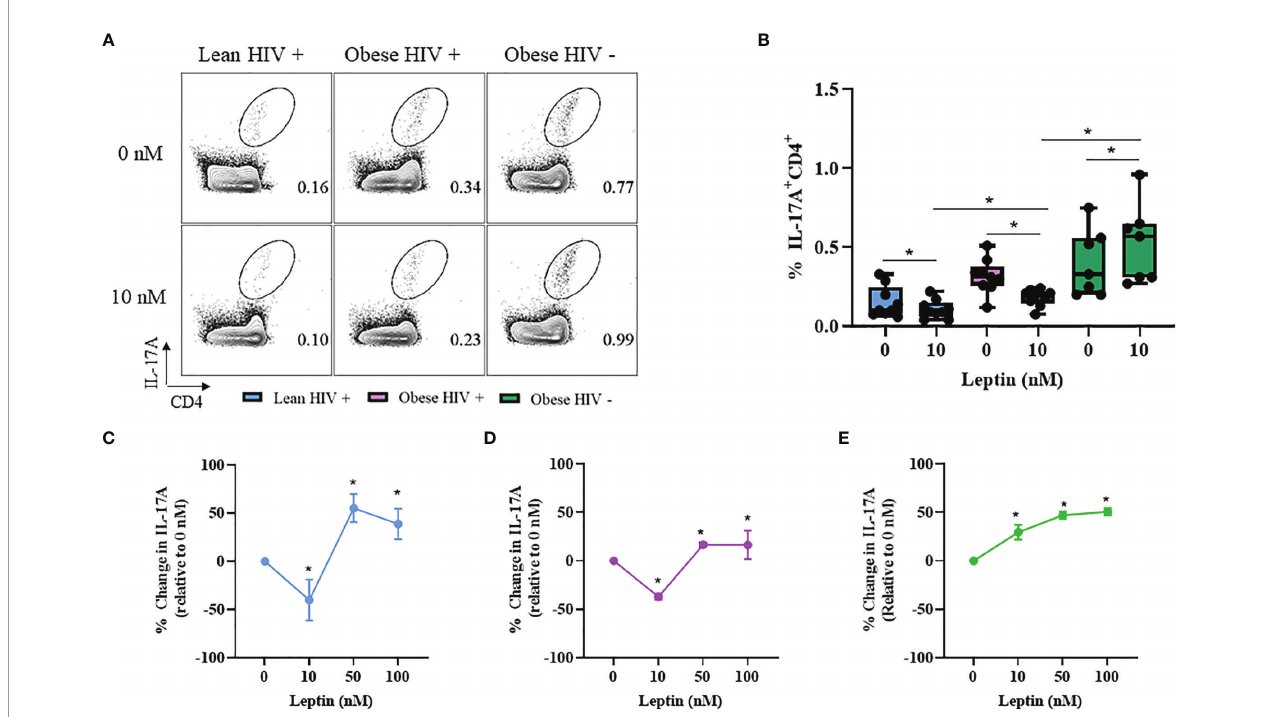
FIGURE 5 | Leptin decreased IL-17A production in CD4 + T cells from obese and lean PLWH but increased IL-17A production in CD4 + T cells from obese HIV- negative controls. PBMCs from obese and lean PLWH as well as obese HIV negative controls were pre-treated with 0 stimulated with PMA/Ionomycin for 6 hours in the presence of 0.07% Golgi-Plug. (A) Representative fl ow gating of IL-17A+CD4+ T cells following 0 or 10 nM leptin treatment conditions. (B) Quanti fi cation of the percentage of IL-17A+CD4+ T cells following 0 or 10 nM leptin treatment conditions. Quanti fi cation of the percentage change in IL-17A production (relative to 0 nM conditions) in CD4+ T cells from (C) lean PLWH, (D) obese PLWH and (E) Obese HIV negative control following 0, 10, 50 or 100 nM leptin treatment. In (B) , Wilcoxon-matched pairs rank signed tests were used to compare 0 and 10 nM values for each person. Mann-Whitney tests were used to compare 10 nM leptin treatment between metabolic groups. In (C – E) , Kruskal-Wallis were used to compare the relative change compared to vehicle treatment in each metabolic group. n = 4-7 people per group. * p < 0.05 was considered statistically signi fi cant. Data shows one representative experiment repeated two